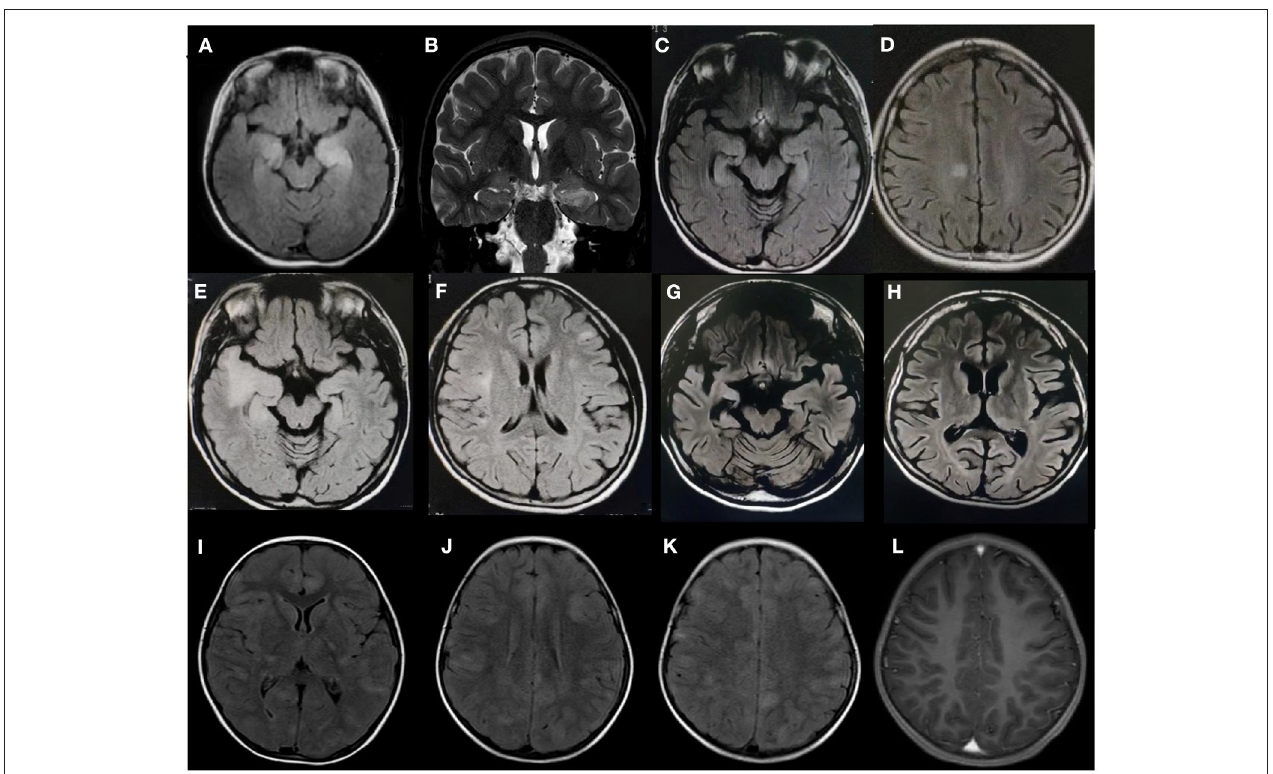
FIGURE 1 | Brain magnetic resonance imaging findings of three patients with anti-glutamic acid decarboxylase 65 (GAD65) antibody-associated neurological syndromes. Patient 1: (A) An axial fluid-attenuated inversion recovery (FLAIR) sequence and (B) a coronal T2 sequence show increased signals in the bilateral hippocampus. Patient 2: (C,D) Axial FLAIR sequences demonstrate hyperintensity in a focal area of the right cingulate cortex and the bilateral hippocampus upon initial presentation, (E,F) new cortical/subcortical lesions at 15 months, and (G,H) progressive atrophy and temporal sclerosis at the 5-year follow-up. Patient 3: (I–K) Axial FLAIR sequences demonstrate diffuse abnormalities in the brainstem, thalamus, basal ganglia, and bilateral cerebral hemispheres; (L) Enhanced MRI shows no